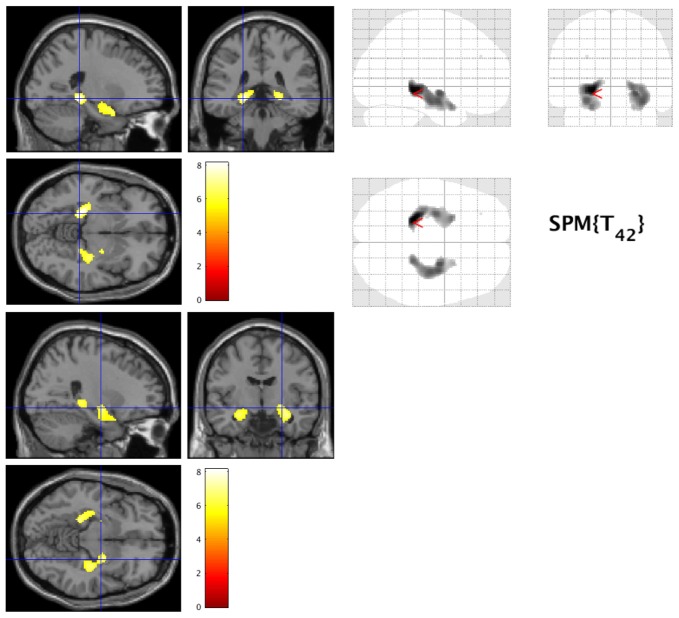
Decreased gray matter volume in early Alzheimer’s disease (AD). The hot spots indicate sites where gray matter’s volume significantly decreased in AD (family-wise error cluster level correction (FWEc) at p < 0.05).